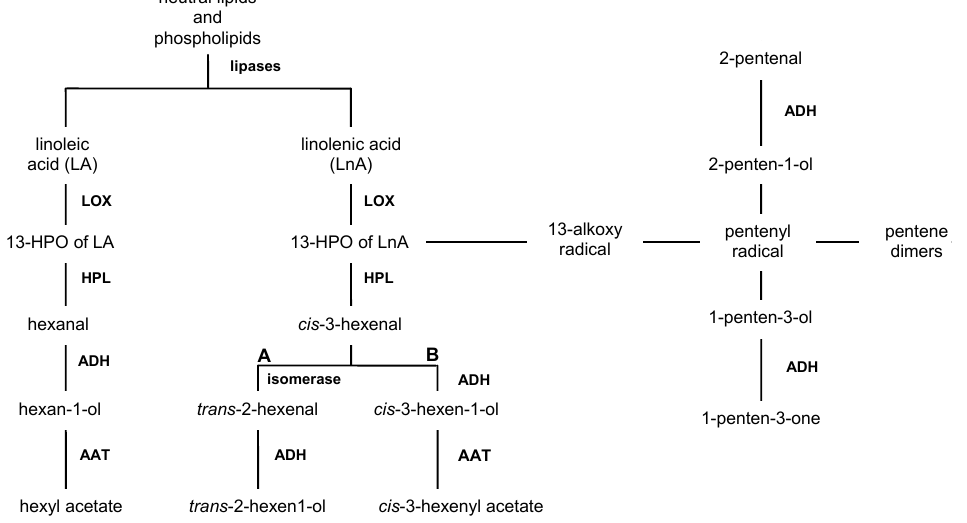
Figure 2. LOX pathway of volatile compounds in VOOs.